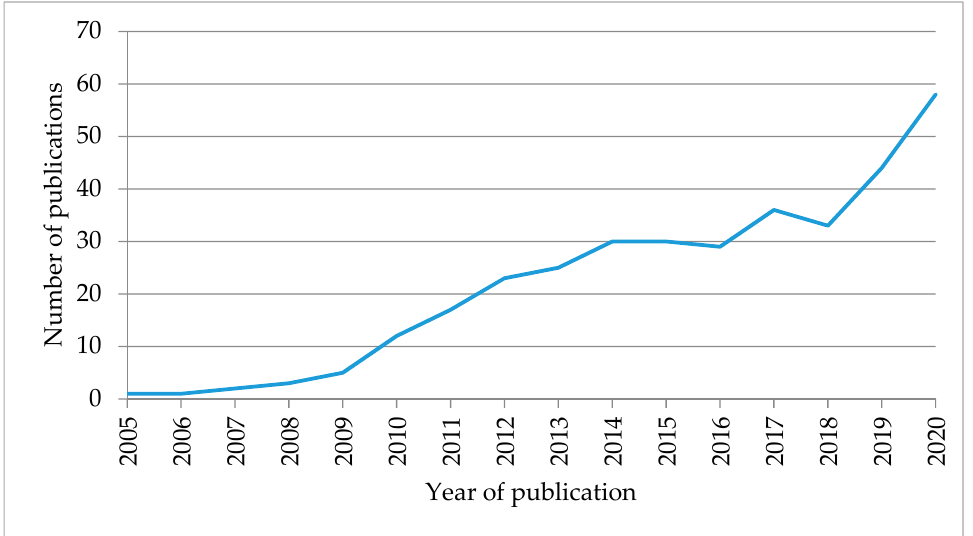
Figure 2. Publications over time on Open Innovation (OI) and university ( n = 349). Source: Prepared by the authors on the basis of WoS data.